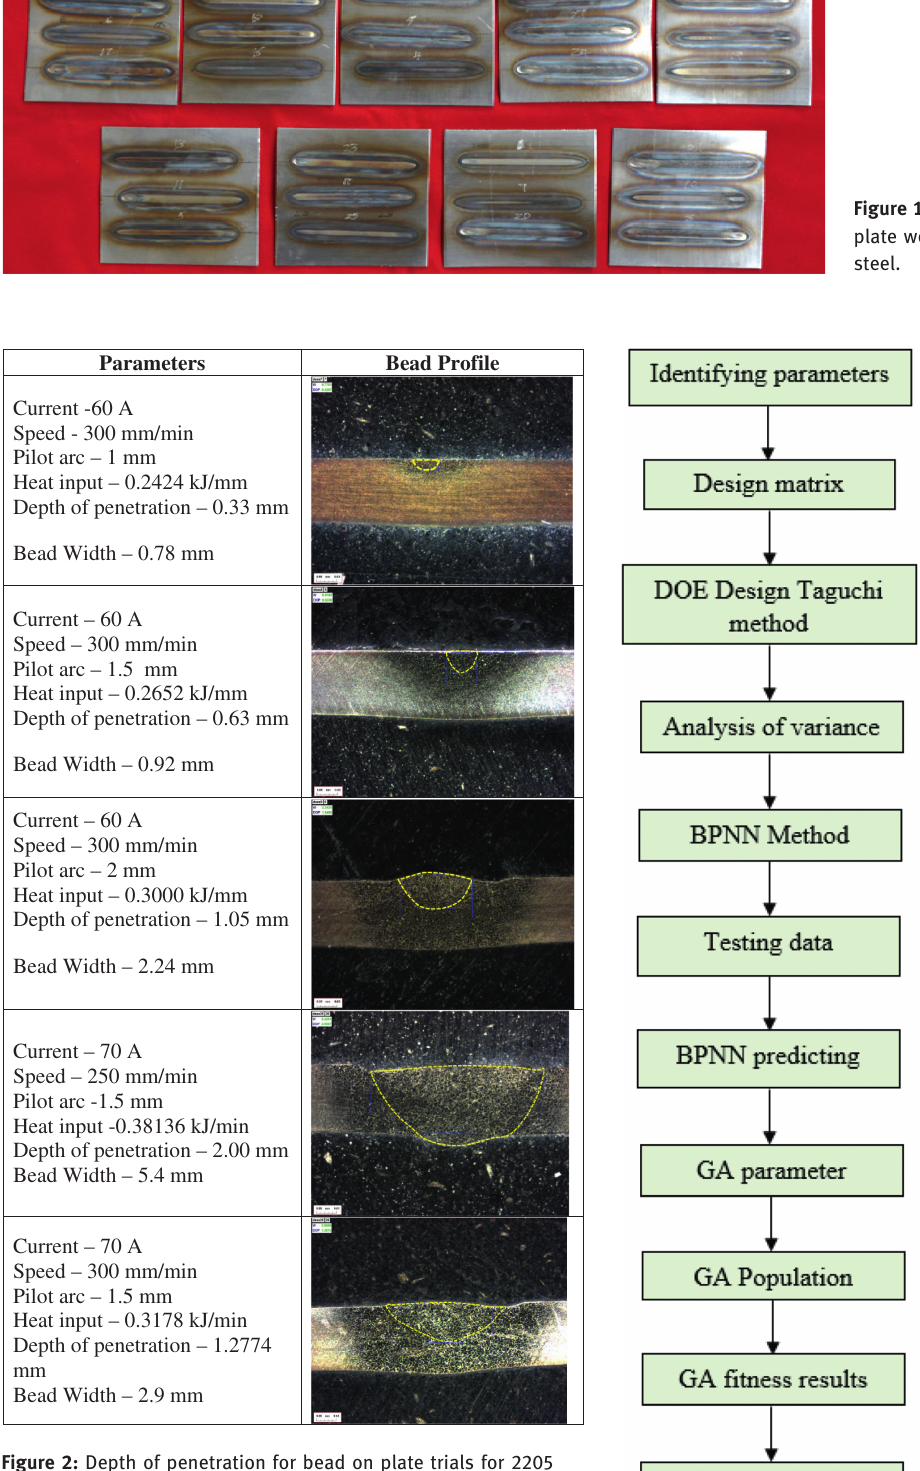
Figure 3: Sequential approach